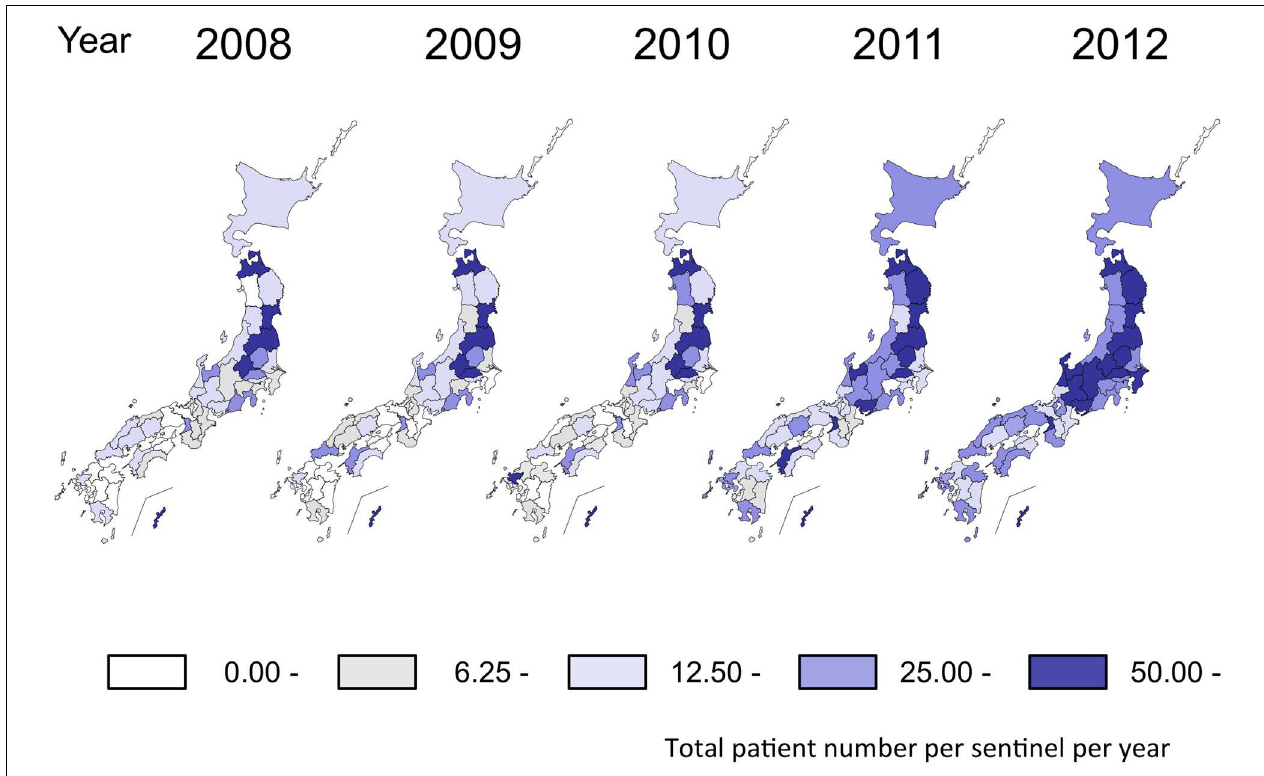
FIGURE 3 | Incidence of M. pneumoniae pneumonia in Japan by prefecture reported by the NESID. The ranges of the number of cases in each prefecture (annual cases per sentinel) are shown in different colors. The figure is adapted from Infectious Agents Surveillance Report (IASR), 33 (10), 2012. http://www.nih.go. jp/niid/en/iasr-vol33-e/865-iasr/2738-tpc392.html.